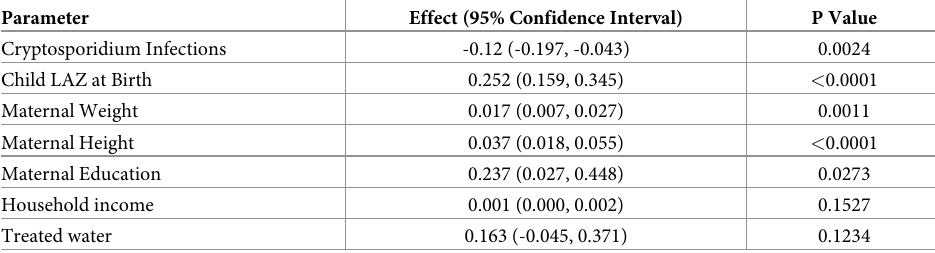
Table 3. Regression Analysis using selected predictors to test the association of Cryptosporidiosis with Height- for-Age Scores at 3 Years.